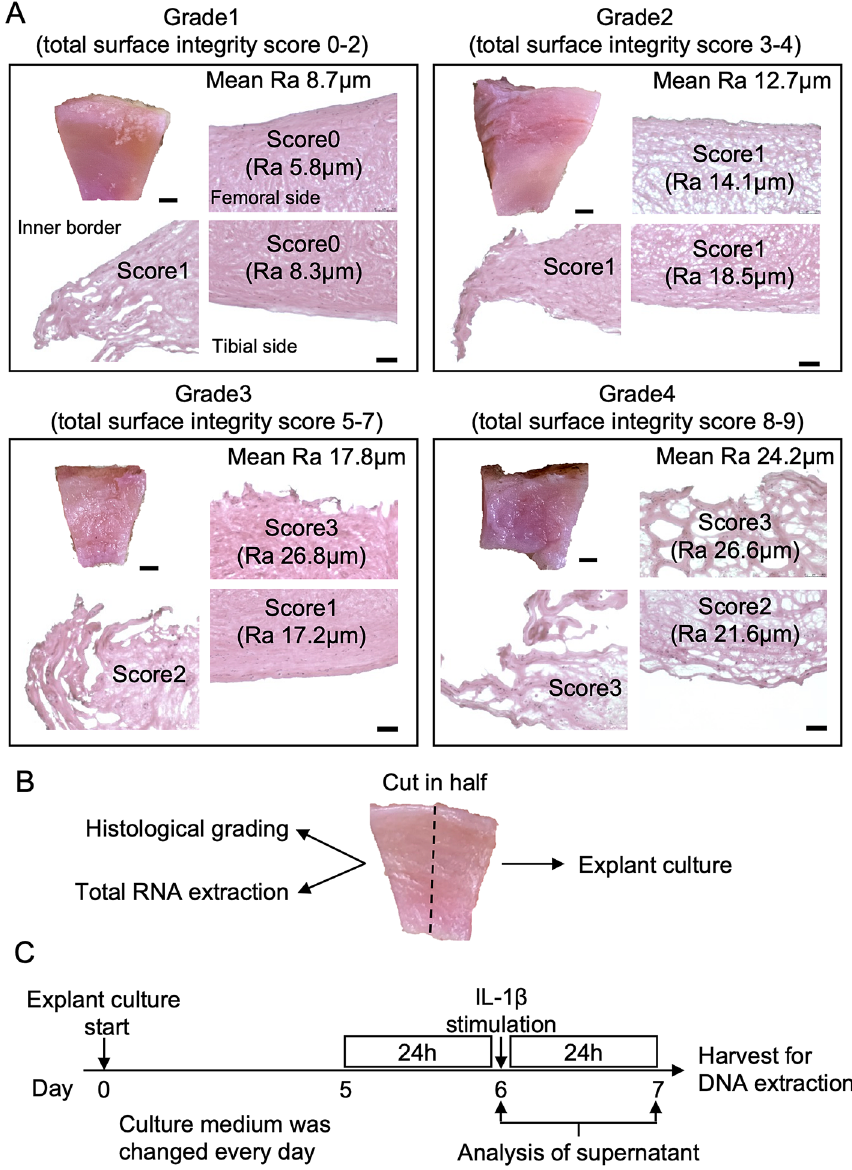
macroscopic and histological findings. Scale bars: 2 mm (macro), 100 μm (H&E). ( B ) Sample preparation. ( C ) Schedule of explant